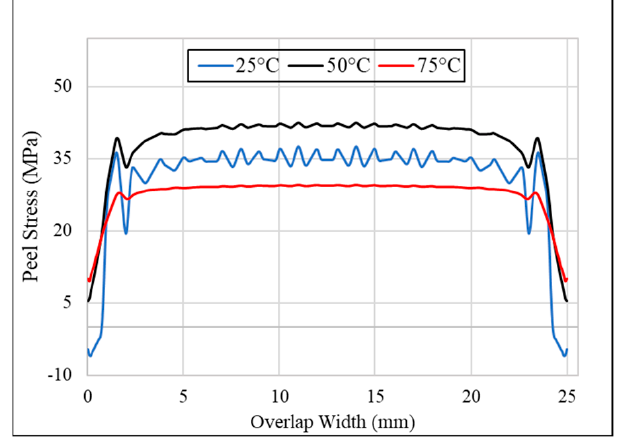
Figure 16. Peel stress distribution at location C of SLJ with Al 2 O 3 nanoparticles in the adhesive at different temperatures.